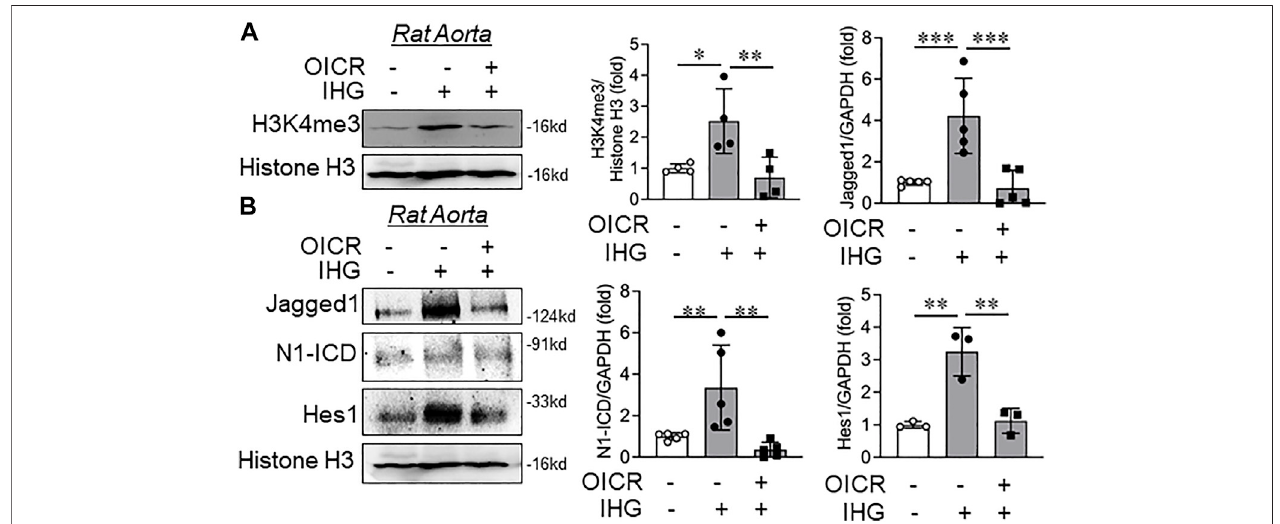
FIGURE 5 | Catalytic inhibition of MLL blocked intermittent high-glucose-dependent increase in Notch ex vivo in rat aorta. (A , B) Immunoblot analysis of tissue lysatescollectedfromrataortatreatedwithintermittenthighglucoseincombinationwithOICR-9429andprobedforH3K4me3( A , n =4),Jagged1( B , n =5),N1-ICD( B , n = 5), and Hes1 ( B , n = 3) along with densitometry quanti fi cation. Values represent the mean ± SD. * p < .05, ** p < .01, and *** p < .001, by the two-stage linear step-up procedure of Benjamin, Krieger, and Yekutielitest.